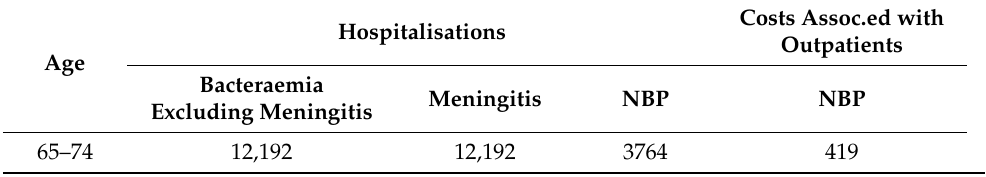
Table 6. Other healthcare costs (EUR).